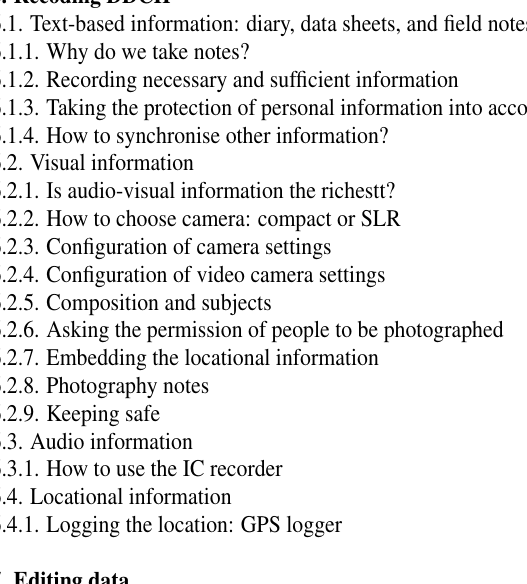
Table 1: Curriculum of the CEDACHeLi